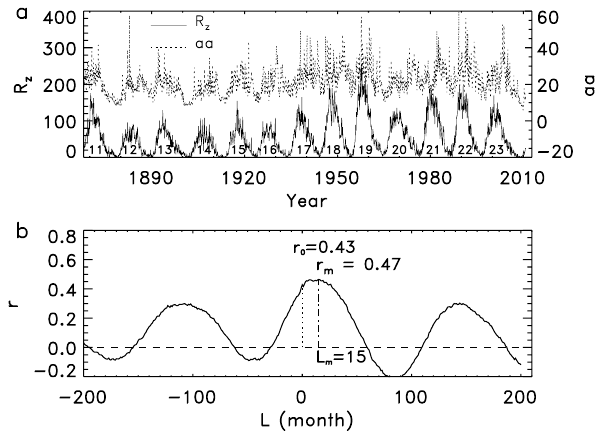
Fig. 1. (a) Monthly R z (solid) and aa (dotted). (b) Correlation function between R z and aa of the lag L = − 200 , − 199, ... , 200 (month).